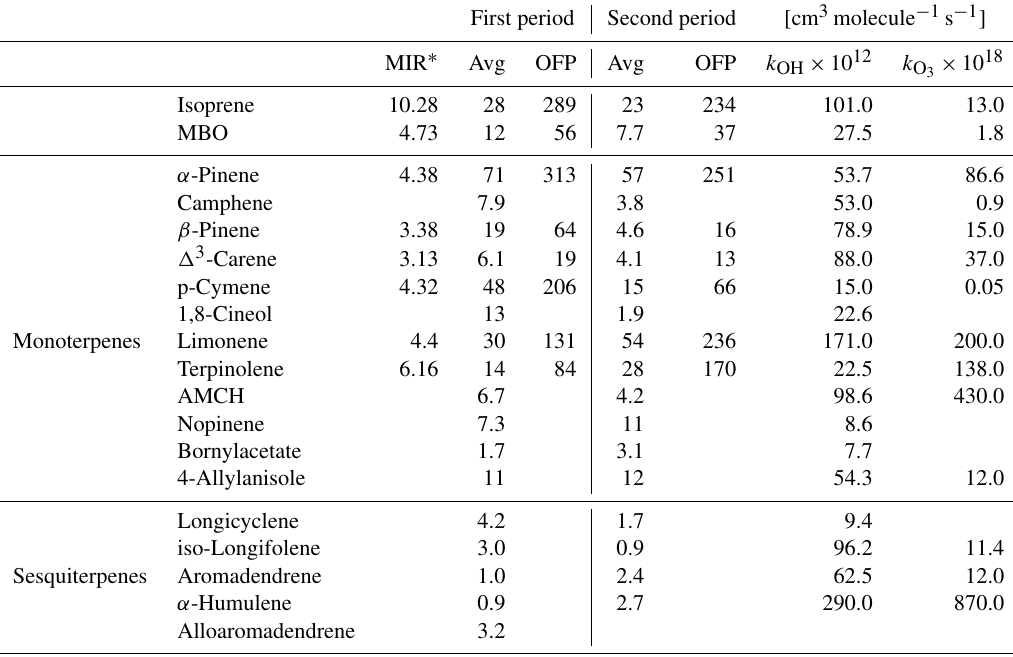
Table 5. Photochemical properties of measured BVOCs during the first and second campaign at